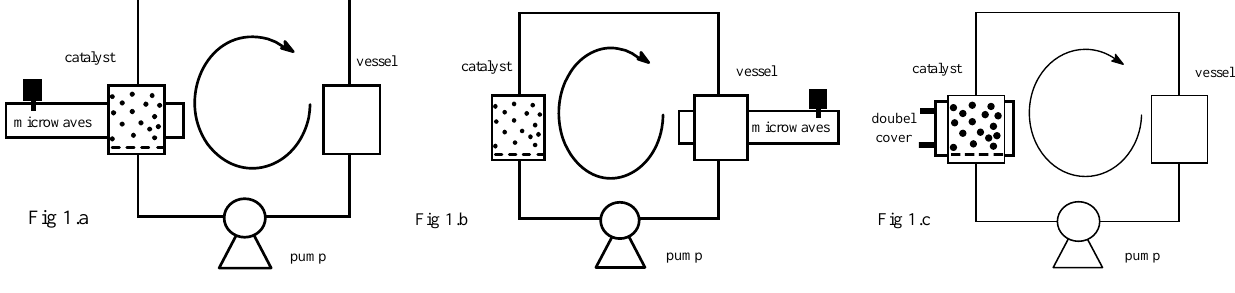
Figure 1. Microwave and classical continuous reactors [4].